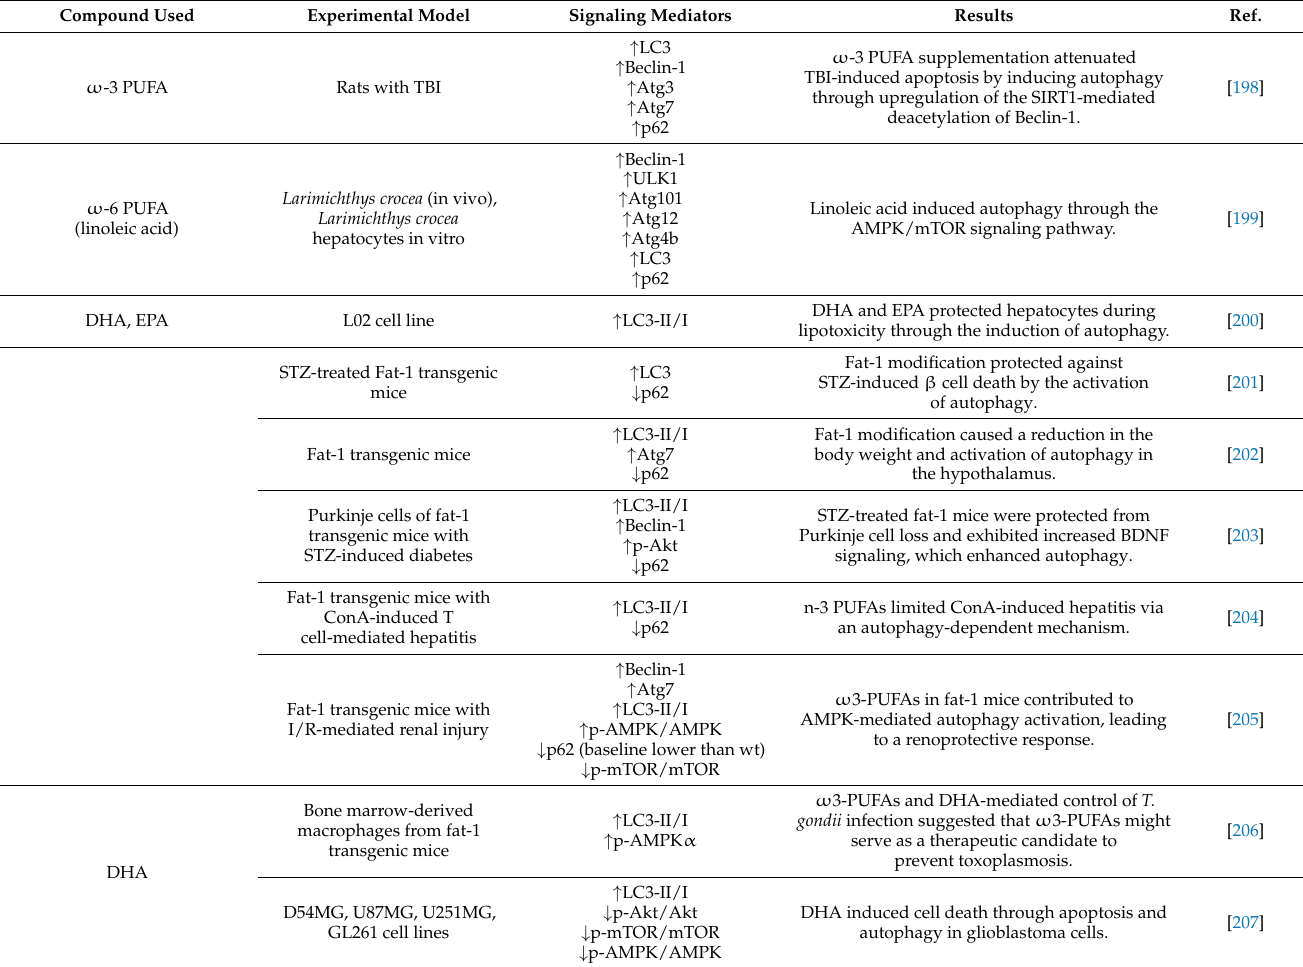
Table 9. Summary of selected available data on the modulation of PUFAs-mediated autophagy. Compound Used Experimental Model Signaling Mediators Results